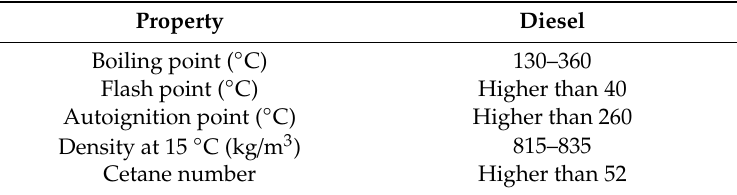
Figure 2. Schematic diagram of constant-volume combustion chamber used of Won et el. [22]. Table 1. The physicochemical properties of